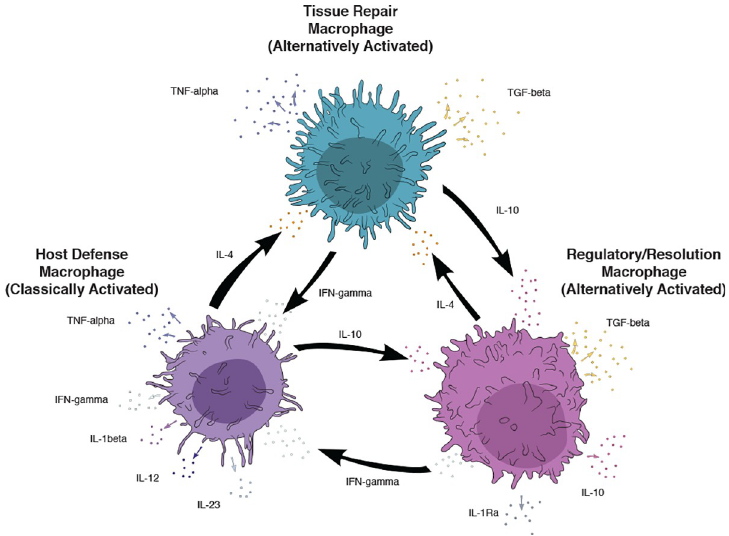
Fig 1. Schematic outlining relationships and properties of polarized macrophages.